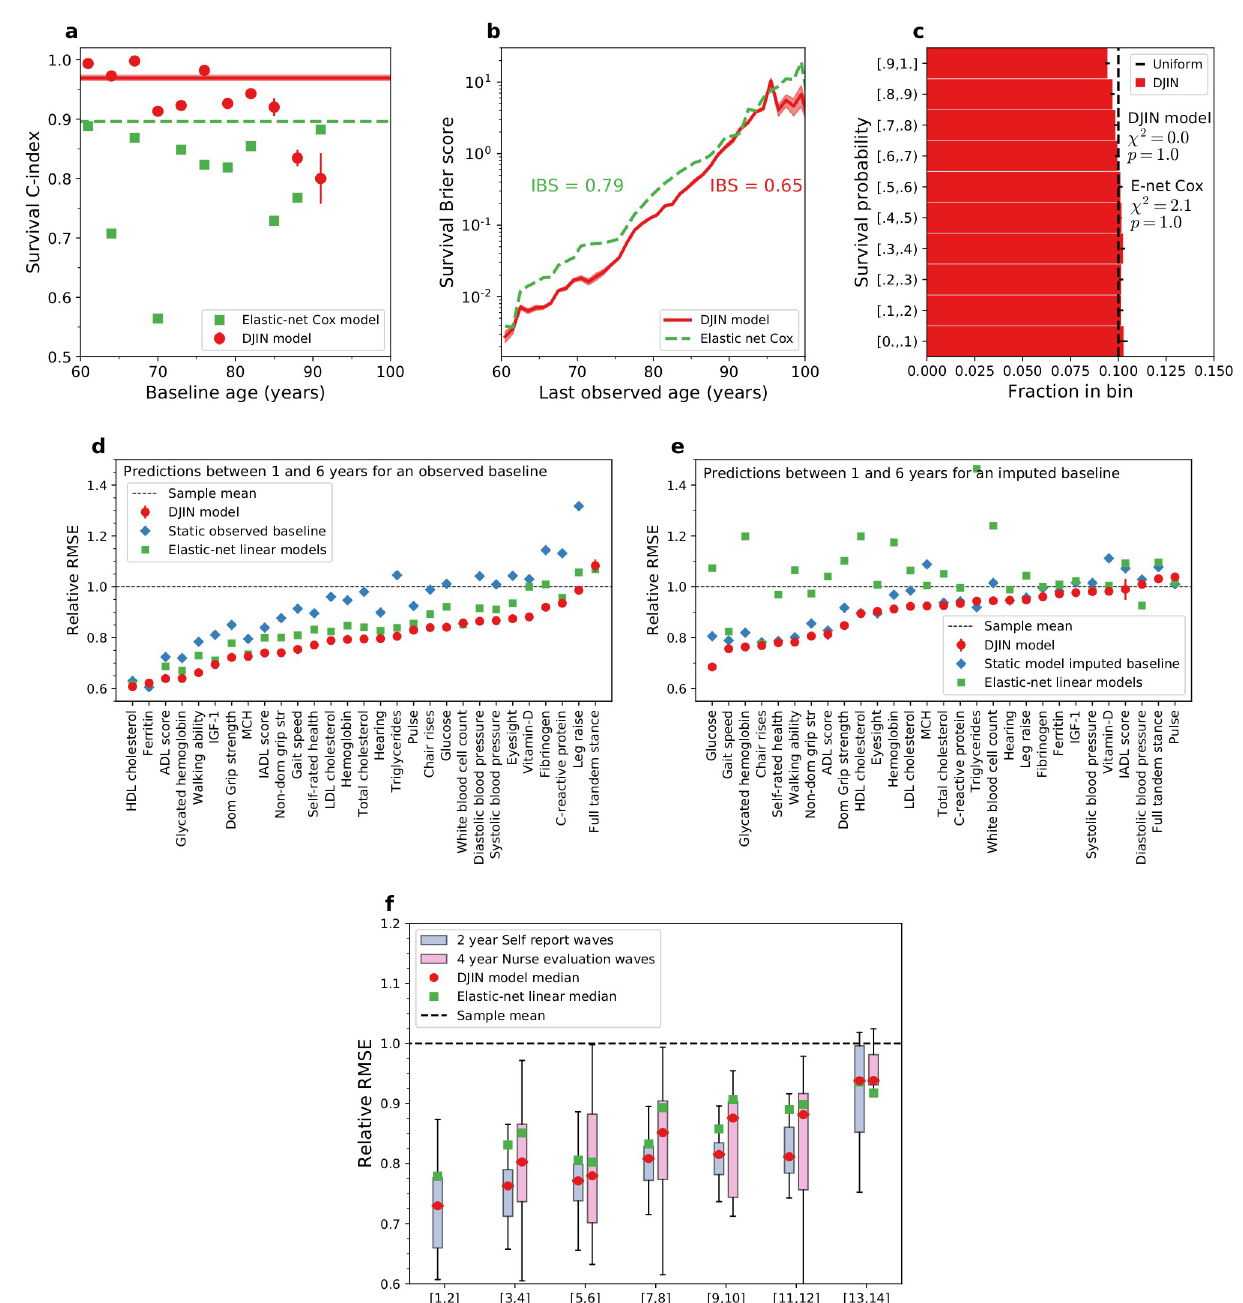
Fig 2. Model predictions and validation. Errorbars for all plots represent standard errors of the mean for 5 fits of the DJIN model. a) Time-dependent C-index stratified vs age (points) and for all ages (line). Results are shown for our model (red) and a Elastic net Cox model (green). (Higher scores are better). b) Brier scores for the survival function vs death age. Integrated Brier scores (IBS) over the full range of death ages are also indicated. The Breslow estimator for the baseline hazard is used for the Cox model. (Lower scores are better). c) D-calibration of survival predictions. Estimated survival probabilities are expected to be uniformly distributed (dashed black line). We use Pearson’s χ 2 test to assess the distribution of survival probabilities for our network model ( χ 2 = 1.3, p = 1.0) and an elastic net Cox model ( χ 2 = 2.1, p = 1.0). (Higher p-values and smaller χ 2 statistics are better). d) RMSE scores when the baseline value is observed for each health variable for predictions between 1 and 6 years from baseline, scaled by the RMSE score from the age and sex-dependent sample mean (relative RMSE scores). We show the predictions from our model starting the baseline value (red circles), predictions assuming a static baseline value (blue squares), and 29 distinct elastic-net linear models trained separately for each of the variables (green squares). The DJIN predictions here come from the same model as for mortality and the elastic net Cox model is also a distinct model. (Lower RMSE is better). e) Relative RMSE scores when the baseline value for each health variable is imputed for predictions between 1 and 6 years from baseline. We